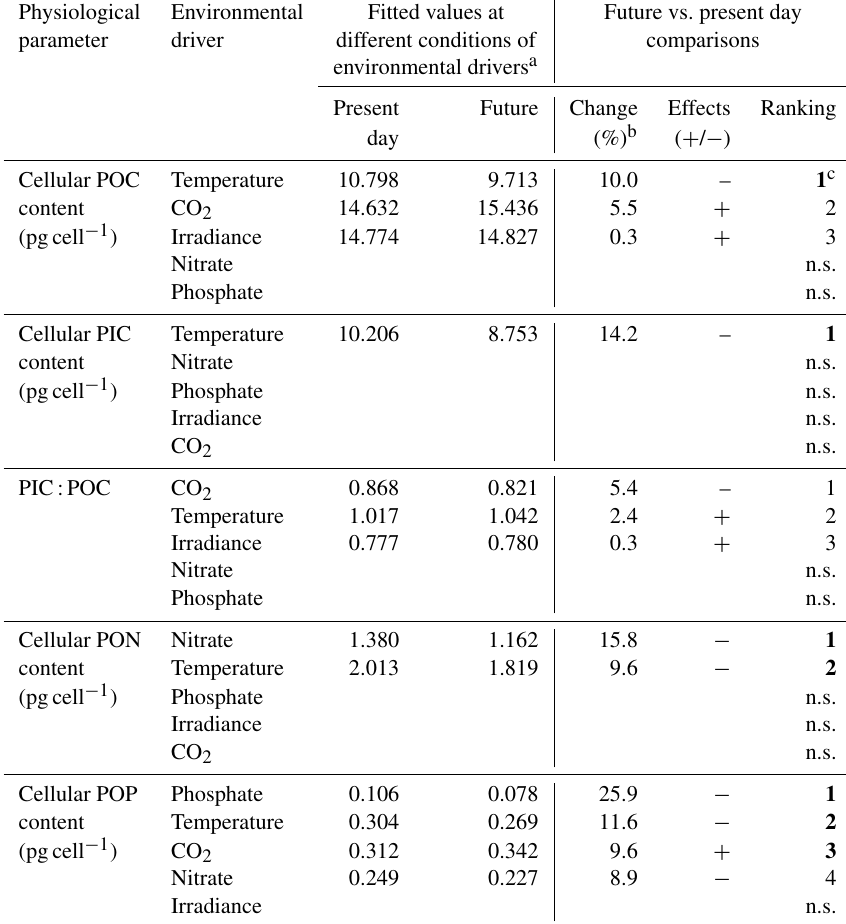
Table 3. Comparison of cellular particulate organic carbon (POC) contents, particulate inorganic carbon (PIC) contents, PIC:POC ratios, particulate organic nitrogen (PON) contents, and particulate organic phosphorus (POP) contents of Emiliania huxleyi between projected (year 2100) and present-day Chatham Rise conditions, with rankings of the importance of the environmental drivers which caused significant effects on each physiological parameter. The numbers of the ranking scheme represent the gradient of the most (1) to least (4) important effects. Effect “ + ” represents an increase and “ − ” represents a decrease in the elemental composition/ratio in the future,